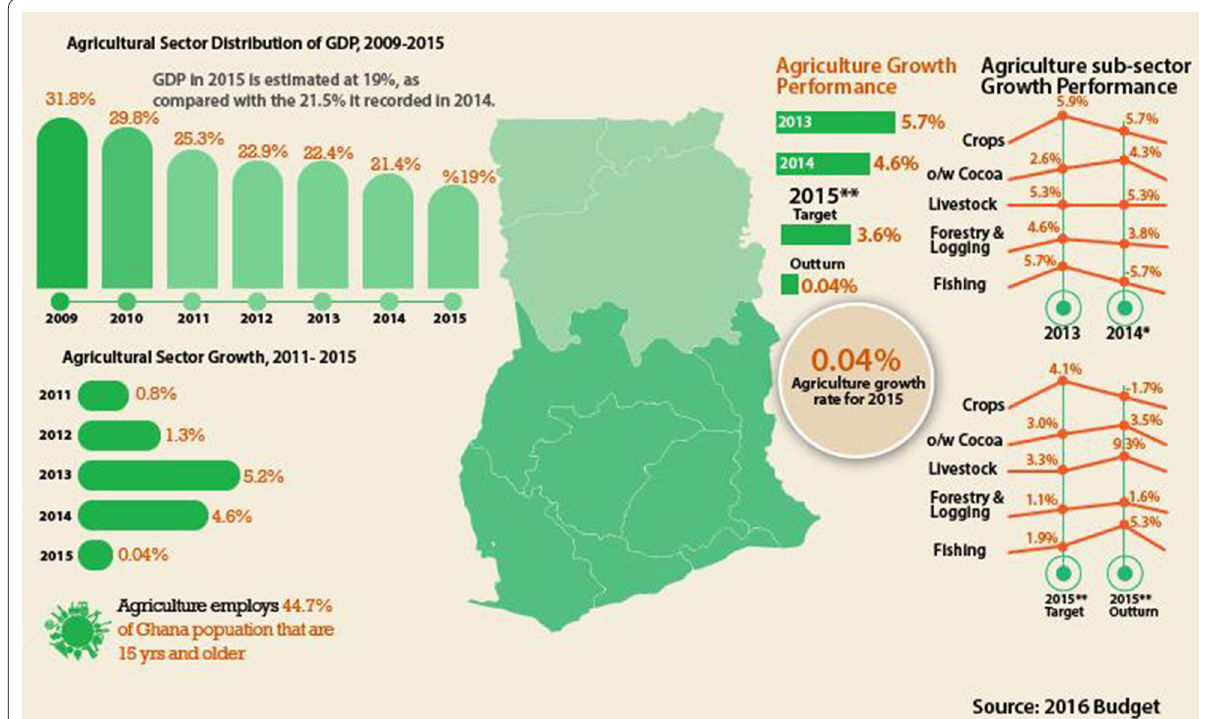
Fig. 1 Trend Analysis of Agricultural Output from 2009 to 2015 in Ghana. Source: Budget statement, 2016 (Adopted from Kwarase 2017; Agbenyo et al.